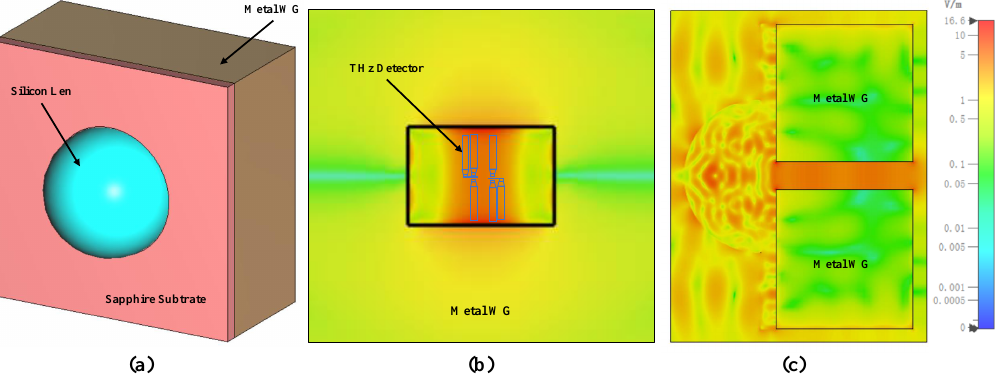
Figure 3. ( a ) The simulated model in CST, which consists of silicon lens, sapphire substrate and metal waveguide. ( b ) The electric field distribution on the surface of THz detector. ( c ) The electric field distribution on the E-plane of the metal